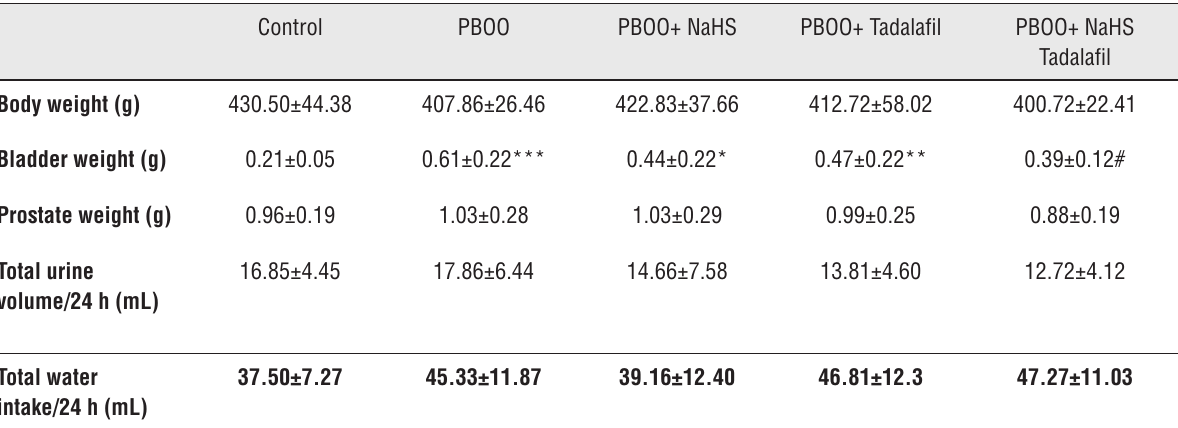
Table 1 - Characteristics of animals in the control, partial bladder outlet obstruction and treated groups at 6 weeks.